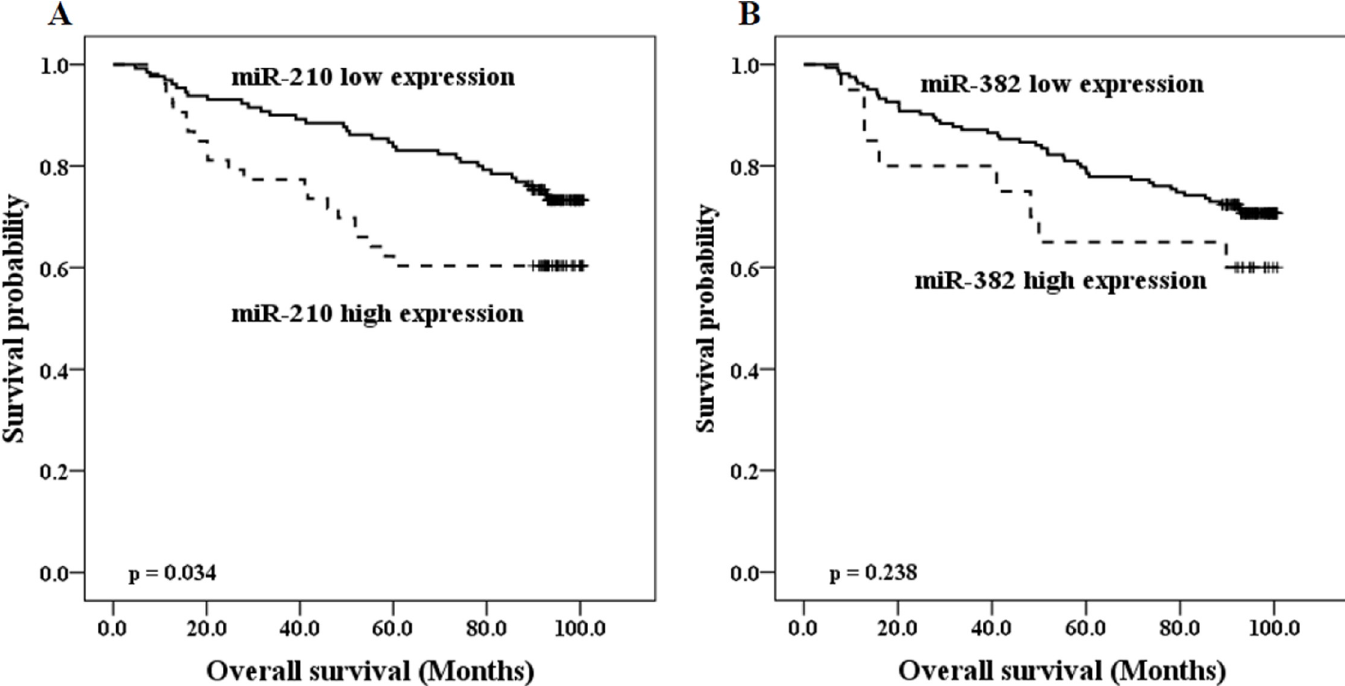
Fig 1. Prognostic values of miR-210 and miR-382 expression in GC patients. Estimated Kaplan-Meyer curves of overall survival for (A) miR-210 and (B) miR-382 in 183 gastric cancer (GC) patients.